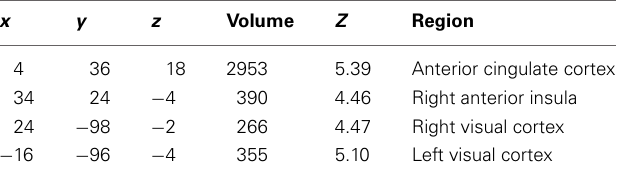
Table A2 | Brain regions showing differential neural activity for high and low reinforcement-values.